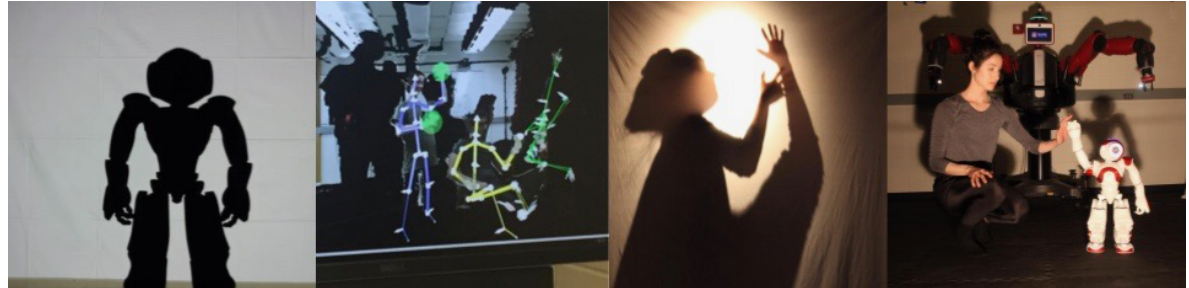
Figure 1: Images showing the themes of Time to Compile . On the left: an obfuscated NAO appears larger due to a projector behind it, pro- jecting the robot onto a screen several feet away. Second from left: floating points of human bodies captured by the Microsoft Kinect. Sec- ond from right: a human altered by an overhead light and a sheet. On the right: a human performer moving with a NAO in the foreground as a Rethink Robotics Baxter stands in the background. These photographs portray the themes of Time to Compile in that they highlight the various ways human bodies are translated across and within pieces of sensor and actuator technology (the hidden human network). The dual shadows give a visual representation to the question, “Are humans becoming more robotic?” if humans are presented in similar con- texts or environments as robots. On the far right, a human “compiles” their emotional, physical, and mental reaction to touching a robot - which could occur instantaneously and then mean something else much later, while it may take an indeterminate and often frustratingly long time for a computer to compile new information or a new